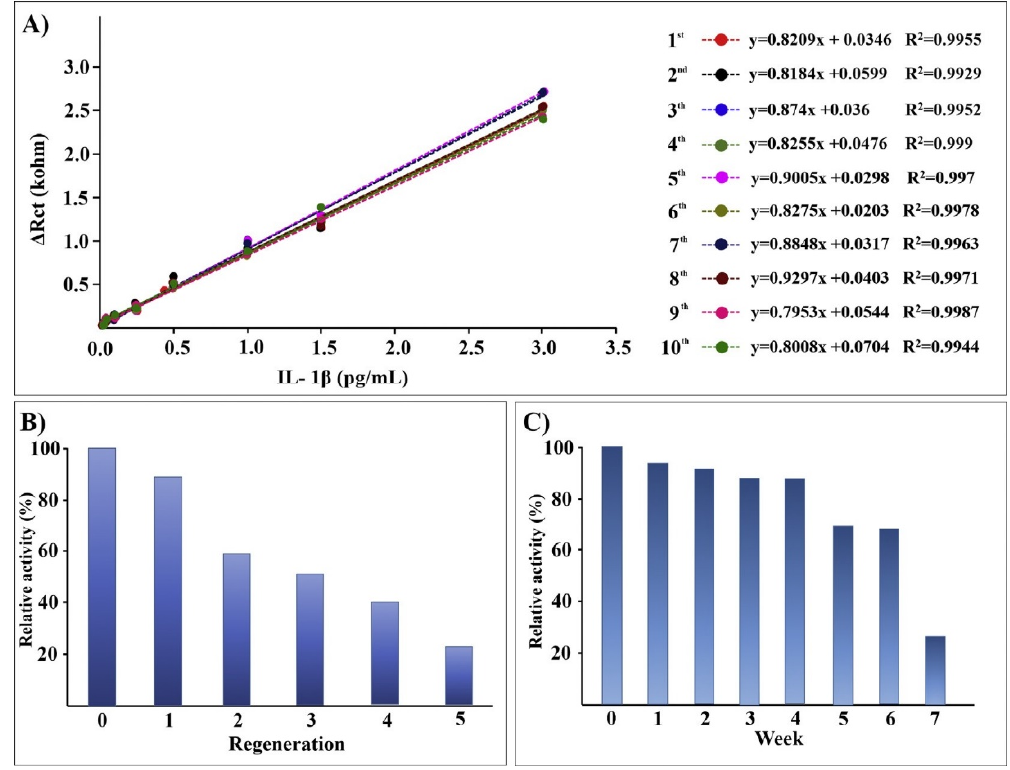
Figure 6. Results for reproducibility ( A ), regeneration ( B ), and storage stability ( C ) for impedance detection of interleukin 1 β (IL-1 β ) atop antibody-coated indium tin oxide (ITO). Reprinted with permission from Ref. [125]. Copyright 2018 Elsevier